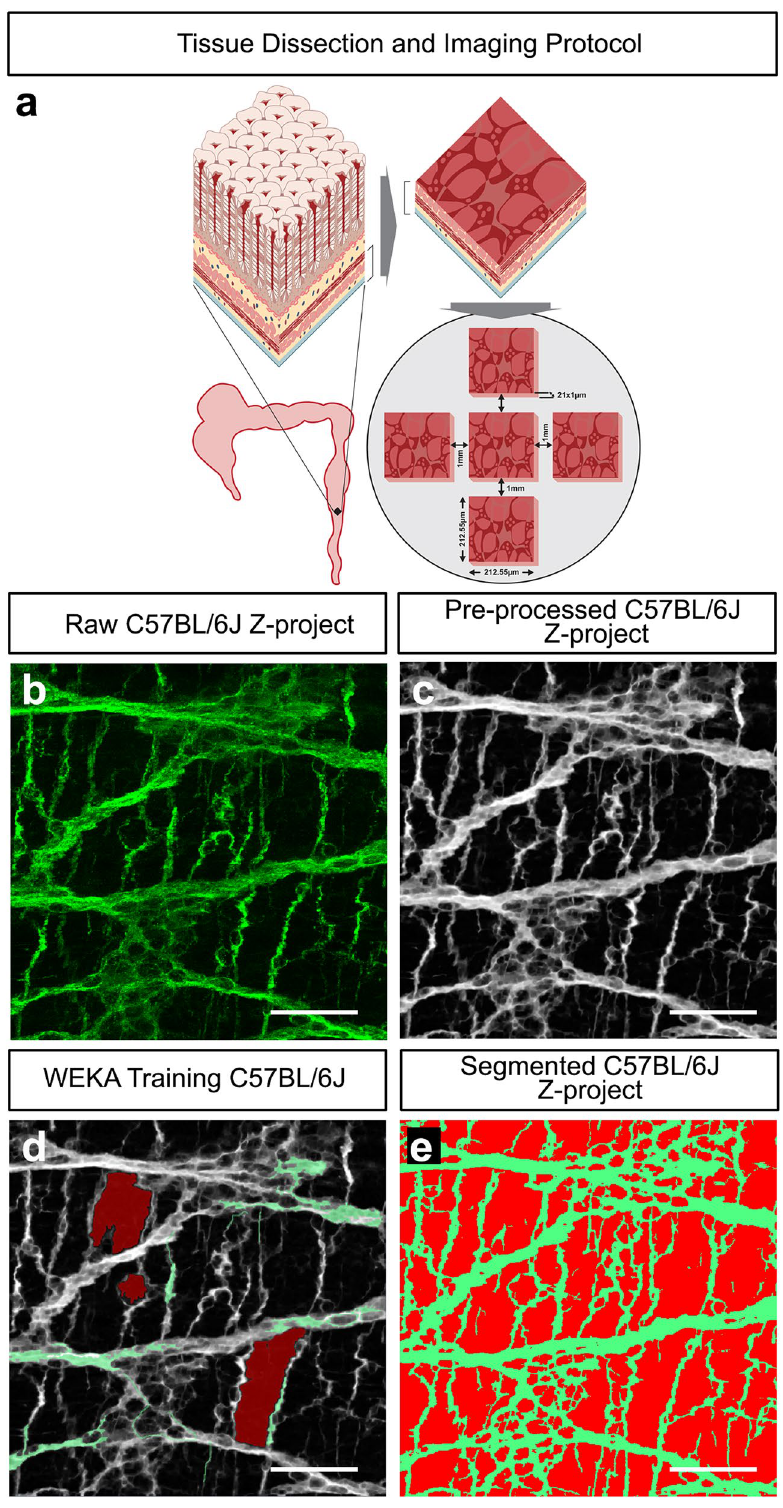
Figure 3. Imaging and segmentation protocol for high-throughput machine learning analysis of the ENS. ( a ) Schematic illustration demonstrating the isolation and dissection of the distal colon along with the confocal imaging protocol used to capture the ENS. Illustration created by UCL Medical Illustration. ( b ) Representative high-power confocal raw z-projection demonstrating the presence of the TuJ1 + (green) ENS in the C57BL/6J distal colon. ( c ) Representative pre-processed image, of b, following filtering to remove noise and improve segmentation. ( d ) Visual representation of WEKA Segmentation process showing segmentation training of the TuJ1 + network (green) and background (TuJ1 − ; red) from the filtered image shown in c . ( e ) Representative image of digitally segmented image d showing pseudocoloured TuJ1 + neural network (green) and background (red). Scale bars, 50